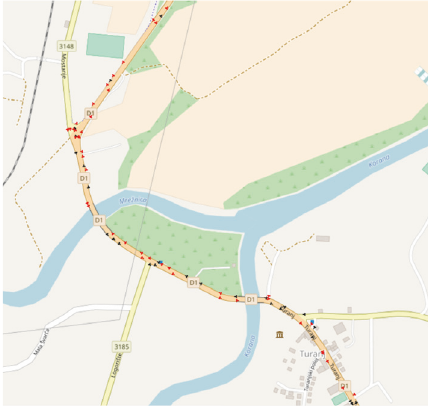
Figure 2: State road D1 with traffic